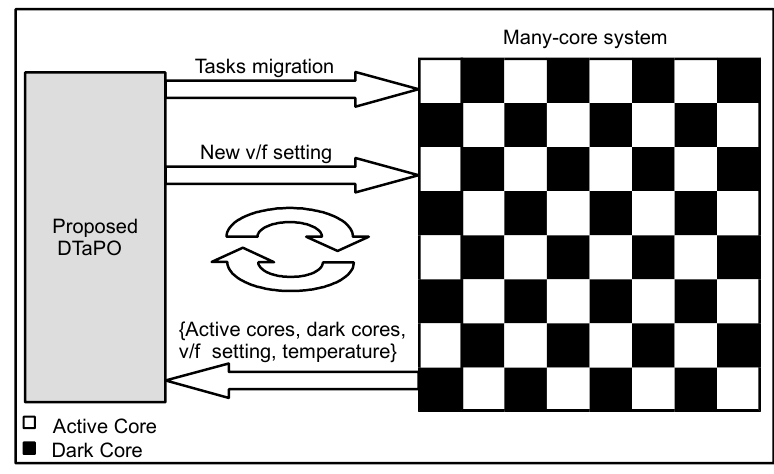
Figure 3. Overview of the proposed